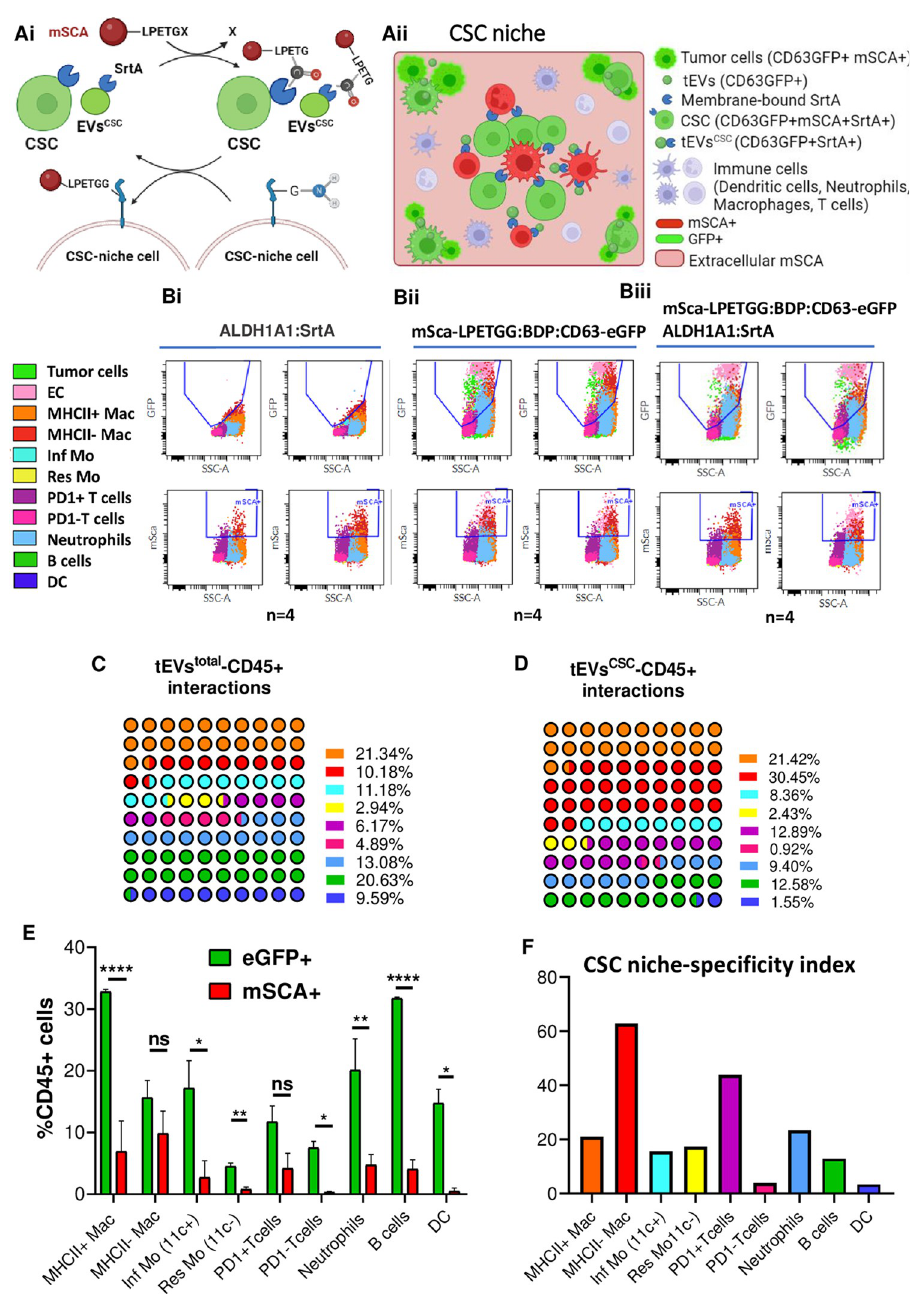
Fig 4. Second-degree labeling via surface interactions reveals short range contacts between CSC, their tEVs CSC and MHC-II–Mac, PD-1+ T cells in the CSC niche. (Ai) Illustrative schemes of SrtA enzymatic activity. SrtA present on the outer membranes of CSC and tEVs CSC catalyzes the transfer of the reporter protein mSca on CSC niche cells. SrtA recognizes the sequence LPETGG. (Aii) Scheme summarizing experimental design to uncover the immune component in the CSC niche. Since only CSC and tEVs CSC express SrtA, this strategy allows to label host cells with mSca reporter based on their proximity to CSC and their EVs. (B) Overlaid plot representation of different cell populations present in tumors from mice bearing genetically modified mEER cells analyzed by flow cytometry. Two plots from n = 4 are presented for each group. (C) Representative graphs showing the % of CD63-eGFP+ immune cells (that is, immune cells binding to tEVs) in analyzed tumors for each of the analyzed subsets with respect to all CD63-eGFP+ CD45+ immune cells. (D) Representative graphs showing the % of mSca+ immune cells (that is, immune cells in the proximity of CSC and their tEVs CSC ) for each of the analyzed subsets with respect to all mSca + CD45+ immune cells. (E) Summary graph presenting the % of immune cell subsets presenting CD63-eGFP+